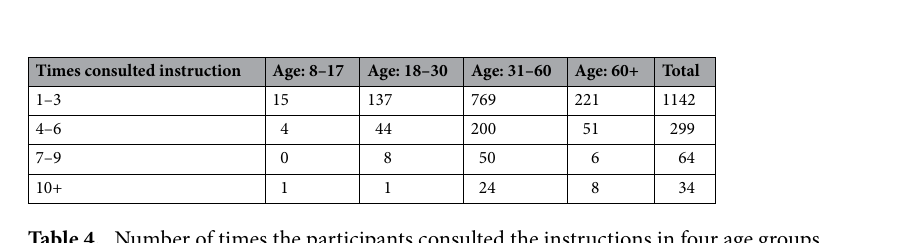
Table 4. Number of times the participants consulted the instructions in four age groups.